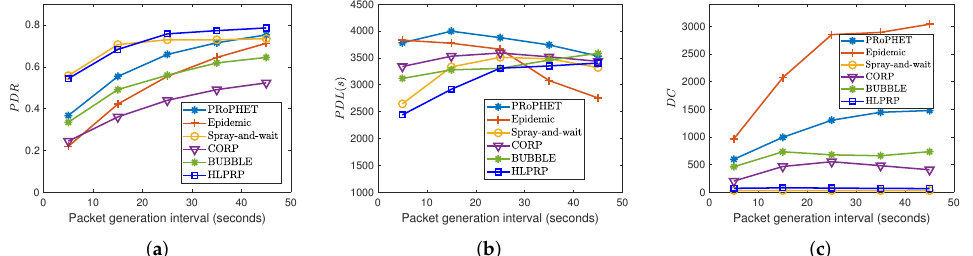
Figure 6. The network performance for various values of the packet generation interval. ( a ) PDR . ( b ) PDL . ( c ) DC